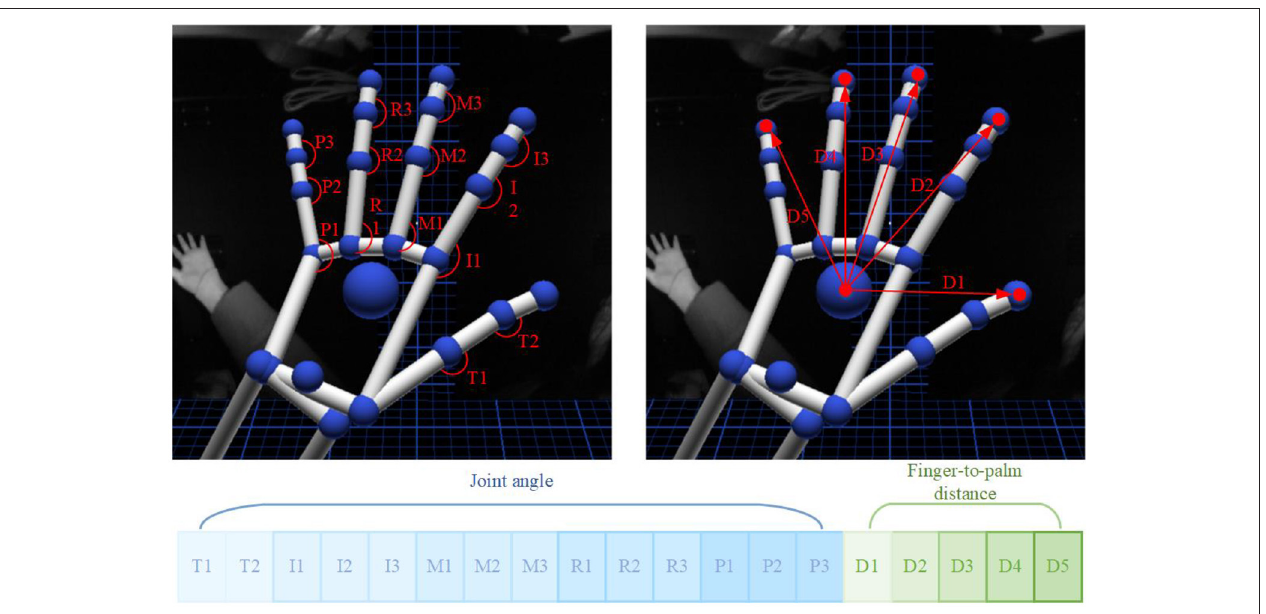
FIGURE 3 | Joint angle and finger-to-palm distance kinematic features were extracted from Leap motion